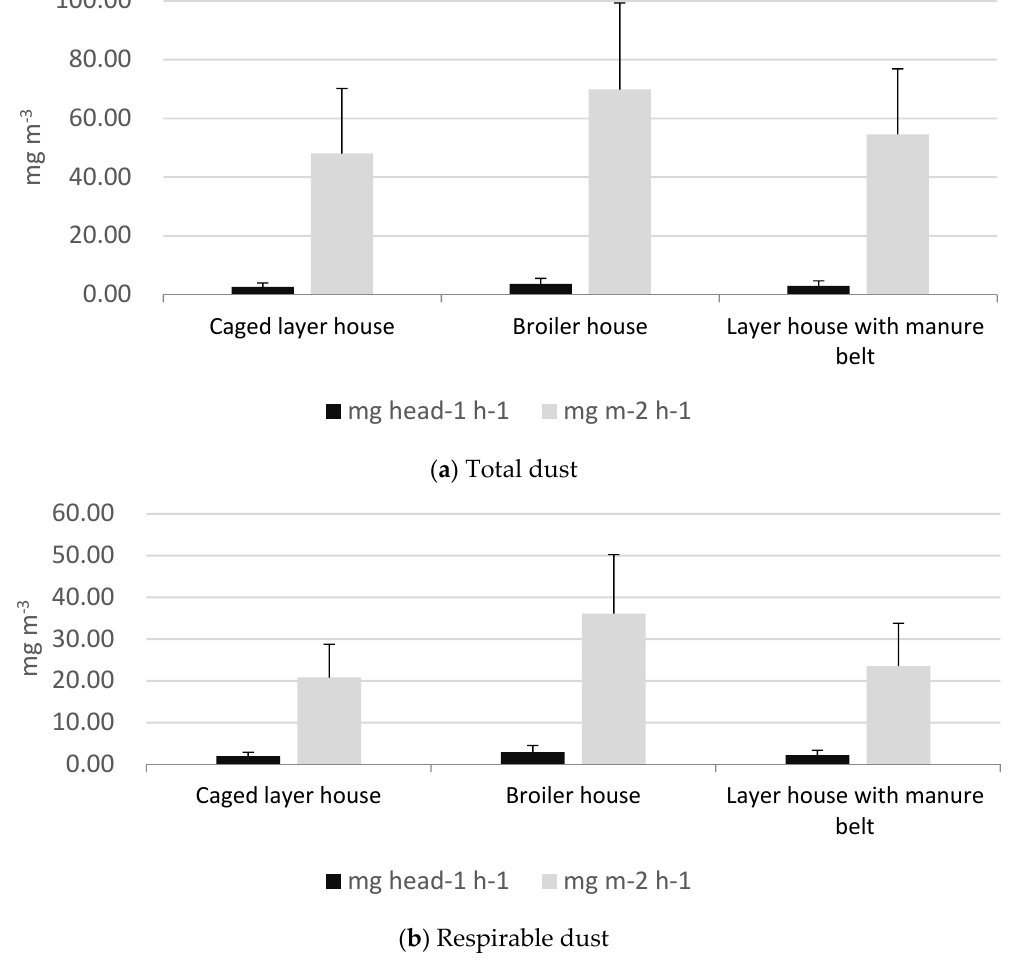
Figure 2. Mean emission rates of total ( a ) and respirable dust ( b ), according to type of poultry house (the error bar represents the geometric standard deviation of the measurement data).